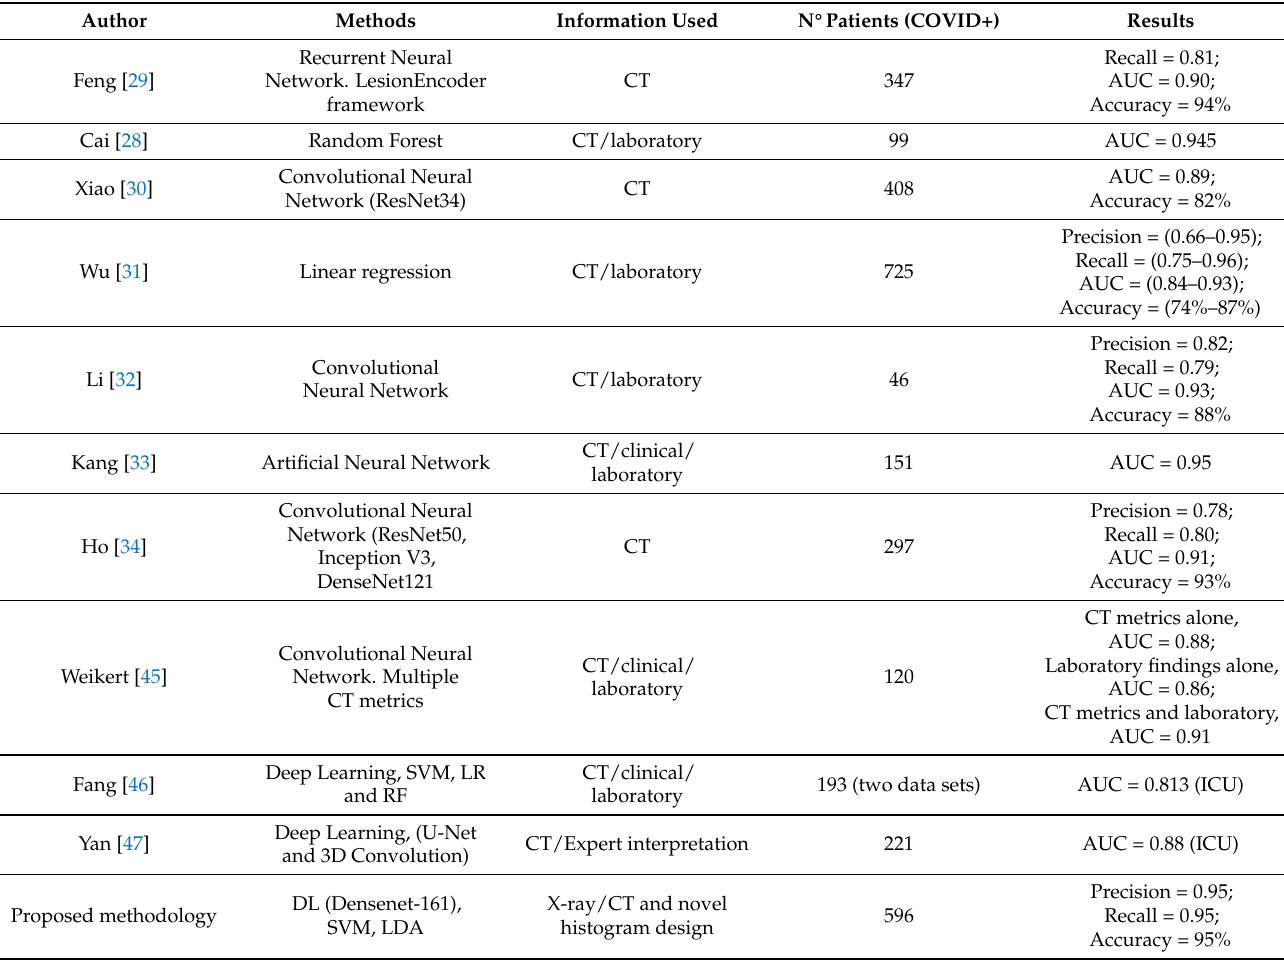
Table 6. Performance comparative of different methodologies presented in the bibliography to predict disease severity of patients with